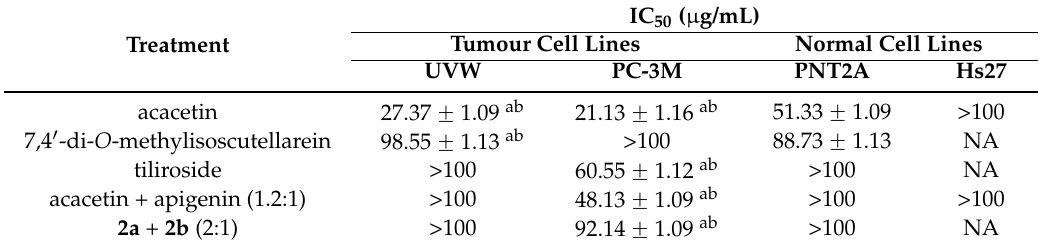
Table 2. IC 50 for 24h treatment with Wissadula periplocifolia compounds in different cell lines.